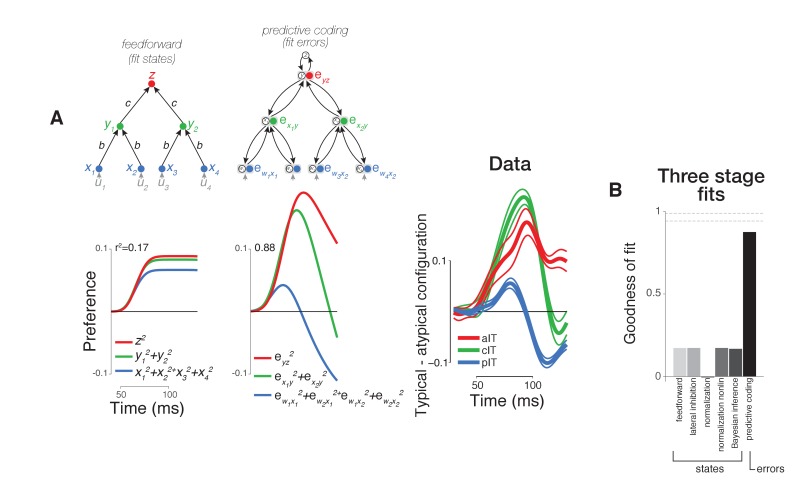
Computational modeling of neural dynamics in IT.(A) Three stage neural networks with recurrent dynamics were constructed to model neural signals measured in pIT, cIT, and aIT corresponding to the first (blue), second (green), and third (red) model processing stages (top row; see Materials and methods). Models received four inputs (gray) into four hidden stage units (blue) which sent feedforward projections that converged onto two units in the next layer (green) (self-connections reflecting leak currents are not shown here for clarity). State (feature) coding models generally showed increasing selectivity over time from hidden to output layers as exemplified by the feedforward model (left) and did not demonstrate the strong decrease of stimulus preference in their hidden processing stage as observed in the pIT and cIT neural population (blue and green lines, feedforward model shown). However, the neurons coding errors in a feedback-based hierarchical model did show a strong decrease of stimulus preference in the hidden processing stage (second column; reconstruction errors instead of the states were fit directly to the data). This model which codes the error signals (filled circles) also codes the states (open circles). Far right, population averaged neural selectivity profile for difference between typical, frontal versus atypical face-part arrangements (normalized by the mean population response to the whole face) used in model fitting (best fitting feedforward and error coding models are shown at left). (B) Goodness of fit of all three stage models tested to population averaged selectivity profiles (dashed lines represent mean and standard error of reliability of neural data as estimated by bootstrap resampling). Besides the base feedforward architecture, additional excitatory feedback (Bayesian inference) or lateral inhibitory (lateral inhibition or normalization) connections between units were implemented to produce recurrent dynamics. The goodness of fit to the population averaged neural data (far right in (A)) of the state coding models (first five bars) and of the reconstruction error coding model (last bar) are shown.